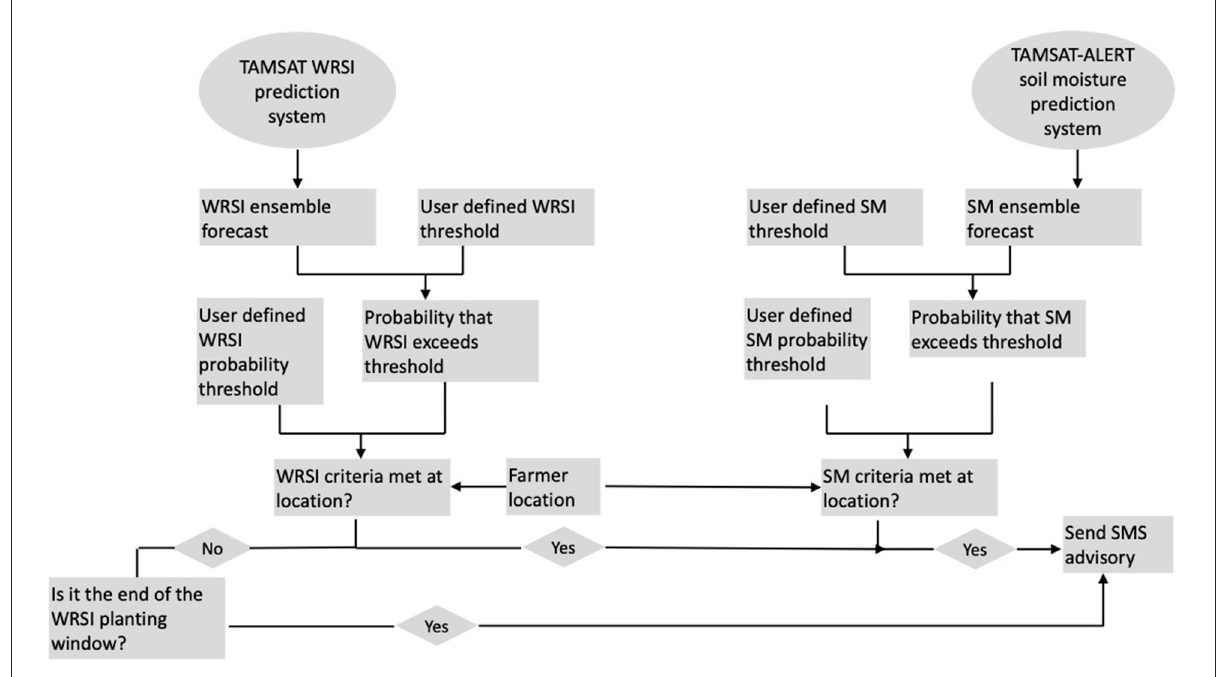
FIGURE2 The conceptual design of the planting date